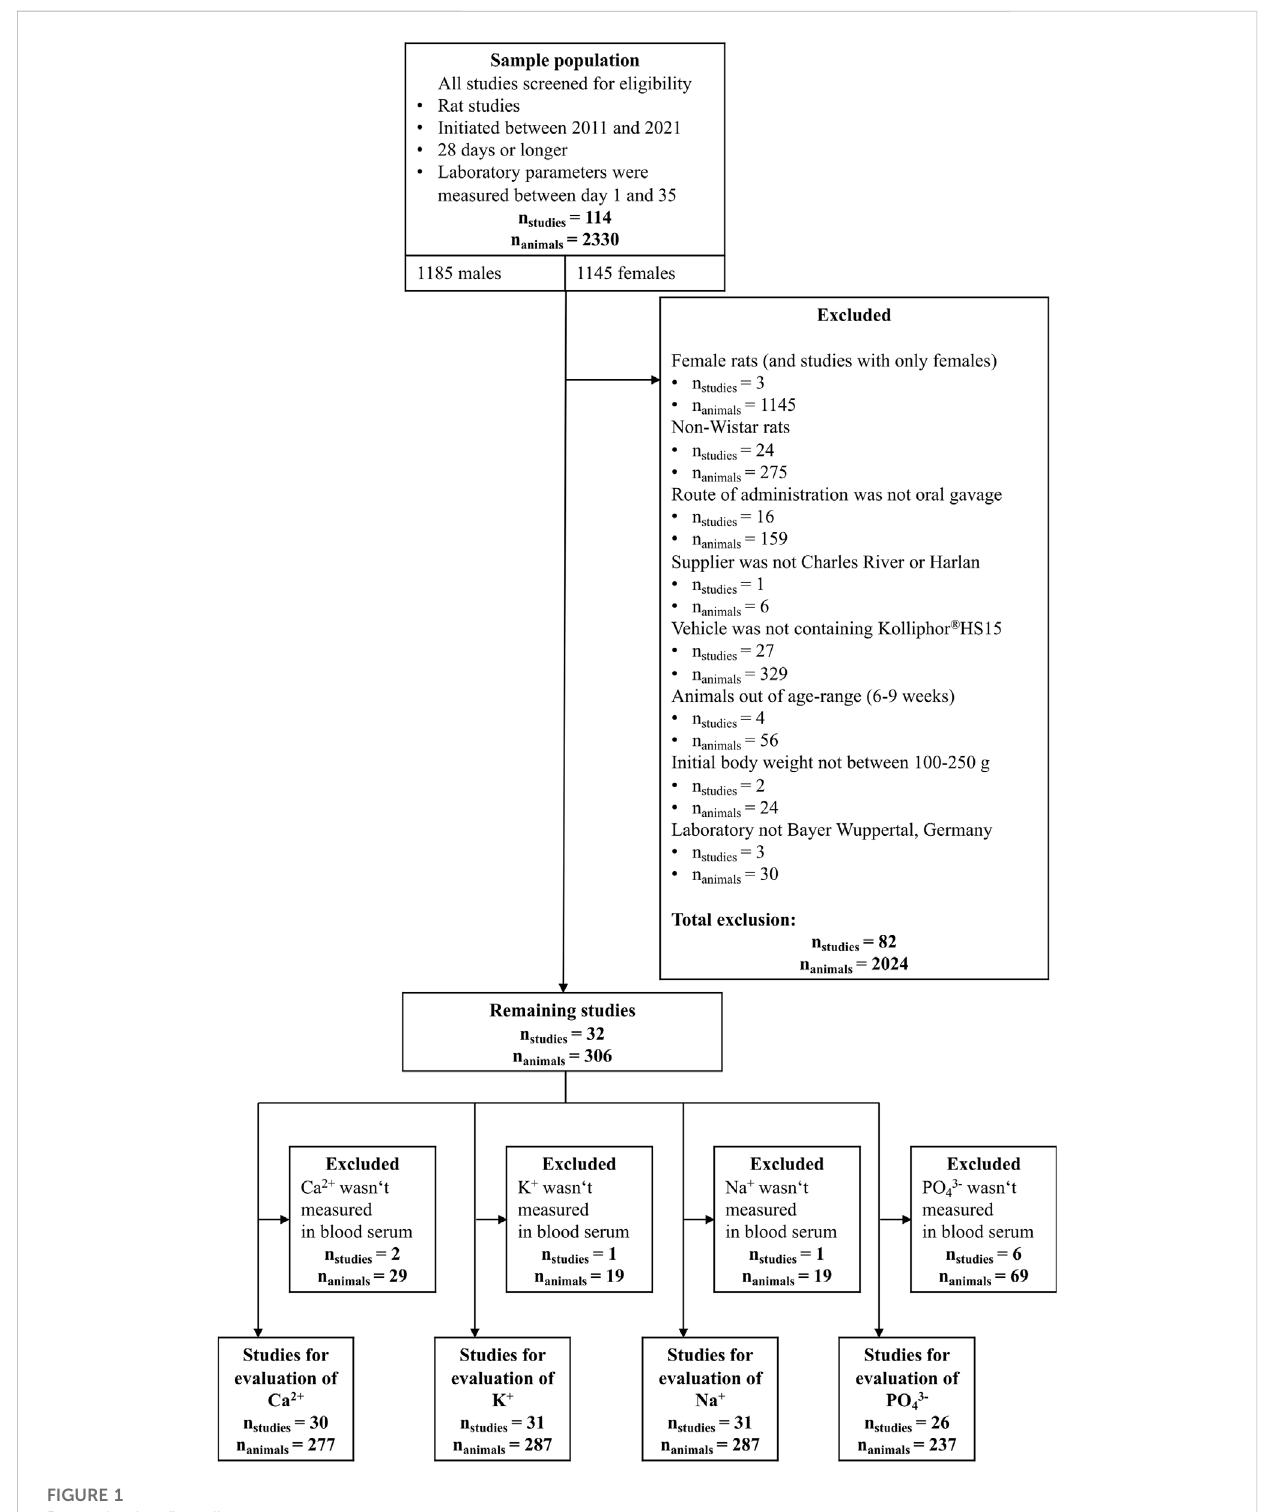
FIGURE 1 Data selection fl ow